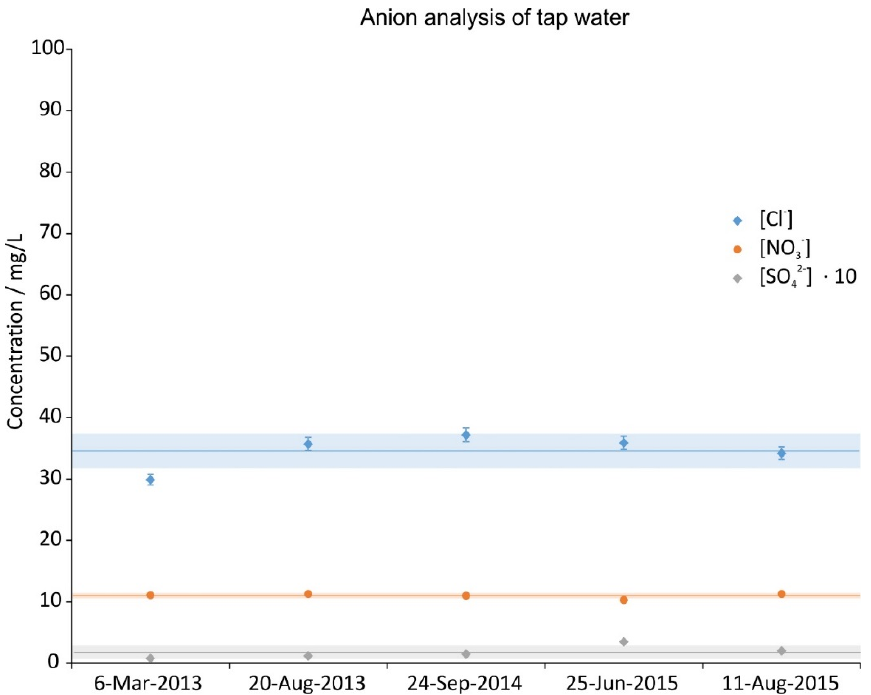
Figure 5. Anion concentration of 5 random tap water samples during the investigation period. The error bars show the precision of the measurement (3%), the lines are the averages and the shaded regions depict the standard deviations over the 5 samples.